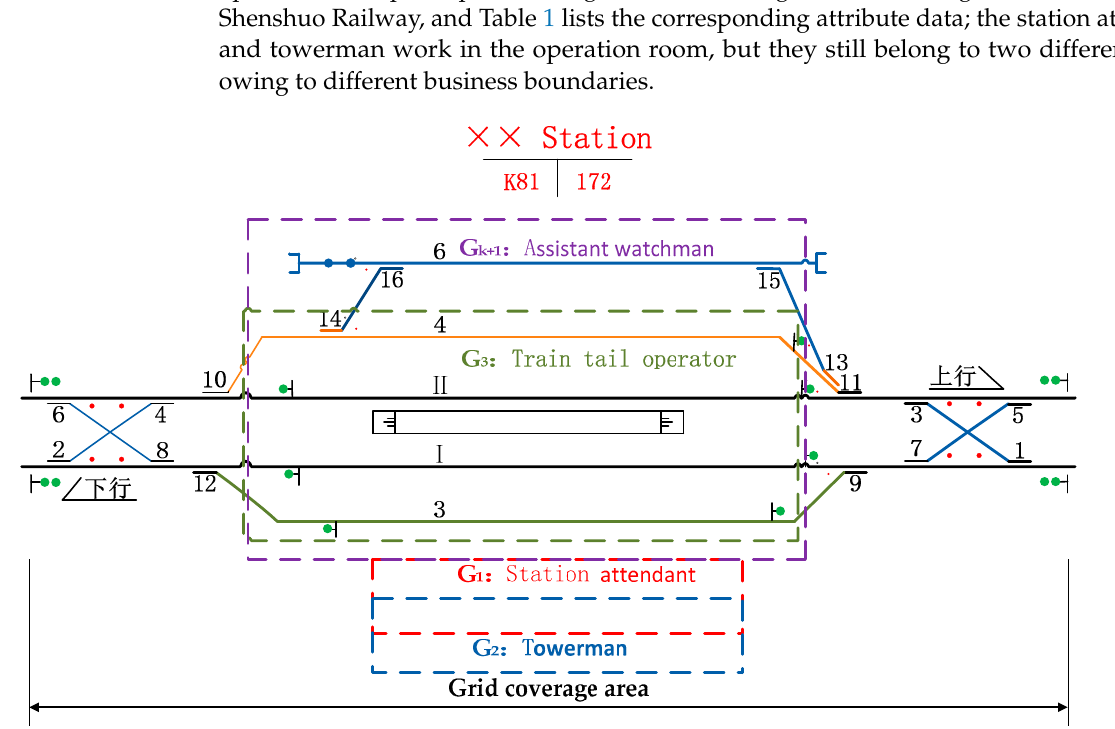
Figure 2. Train operation department grid division. Table 1. Grid attribute data of the train operation department.